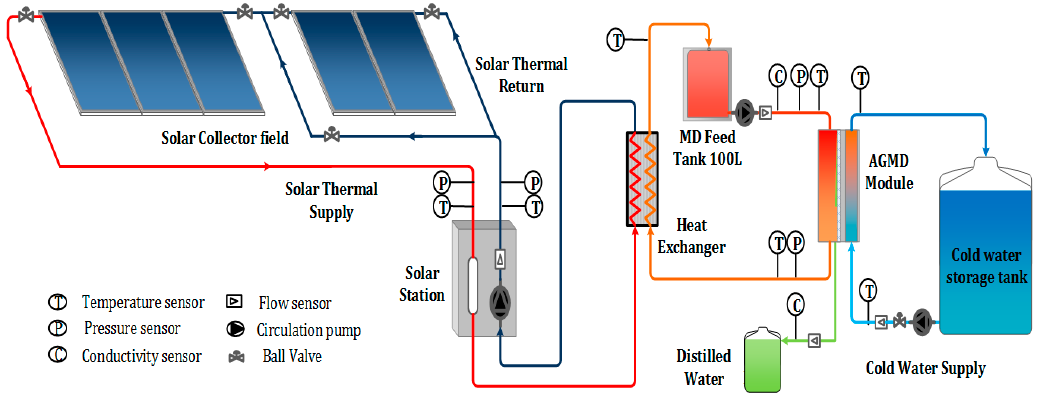
Figure 3. Schematic showing individual operation of solar membrane distillation (SMD).